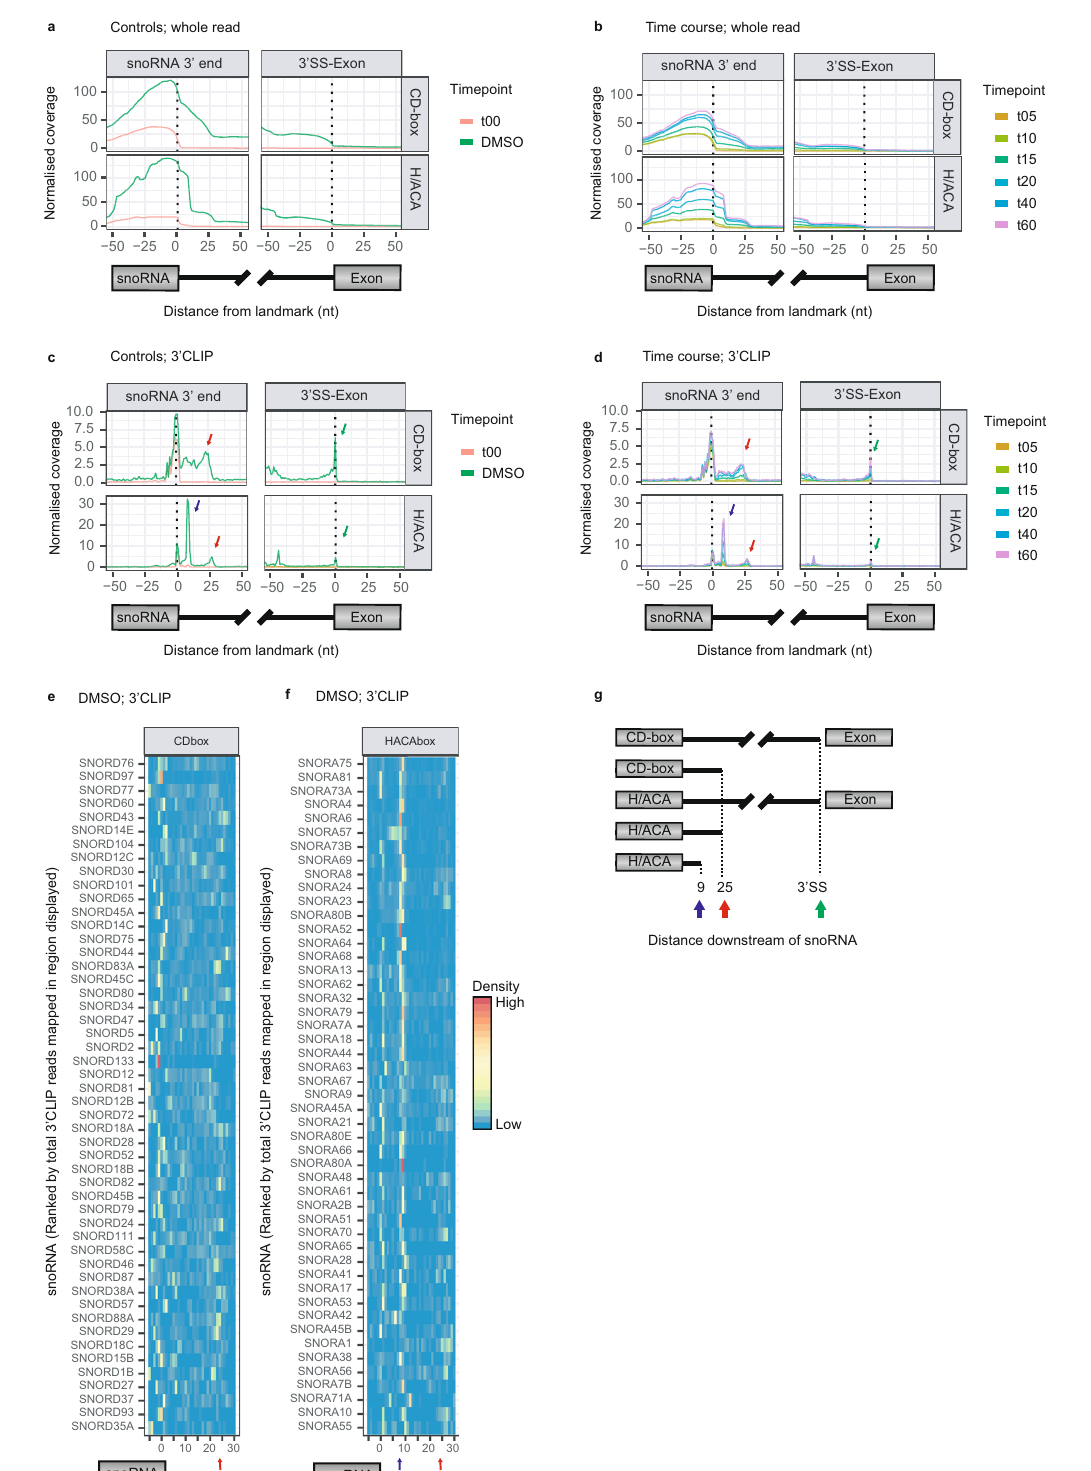
Fig. 6 | RBM7 binds speci fi c snoRNA intermediates. a , b Whole tiCLIP read cov- erage of RBM7 plotted around a 101nt window centred on snoRNA 3 ′ ends (left panel)ortheirdownstream3 ′ SS(rightpanel).Pro fi leswerestrati fi edbyCD-andH/ ACA-boxsnoRNAclassesasindicated.DMSOandt00samplesareshownin a ,while all timepoints are shown in b . c , d as in a , b but plotting 3 ′ CLIP data. Coloured arrows indicate common 3 ′ CLIP data peaks. Blue colour is unique for H/ACA